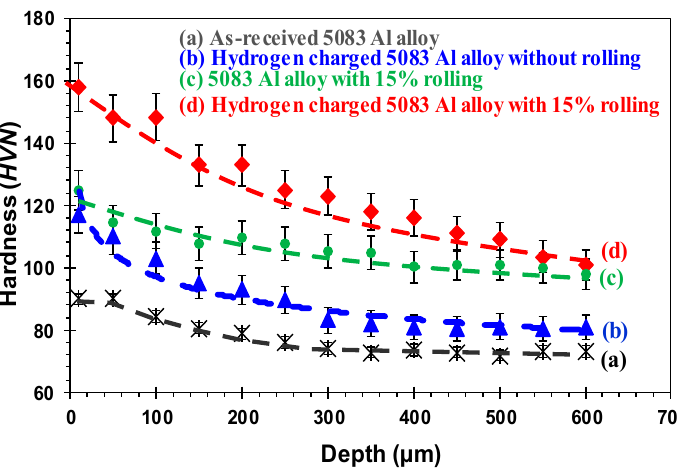
Figure 3. Hardness profile of ( a ) as-received 5083 aluminum alloy, ( b ) hydrogen charged 5083 aluminum alloy without cold rolling (30 mA/cm 2 for 6 h), ( c ) 5083 aluminum alloy with 15% cold rolling, and ( d ) hydrogen charged 5083 aluminum alloy with 15% cold rolling (30 mA/cm 2 for 6 h), as a function of diffusion depth.